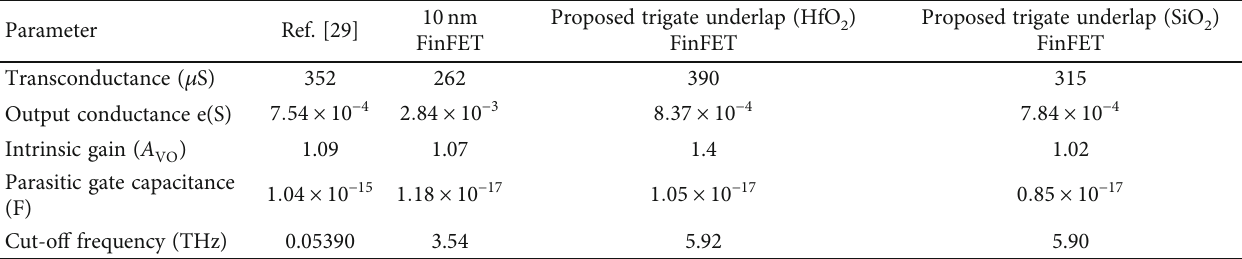
Table 1: Comparison of analog performance parameters for n -type 10nm FinFET device.